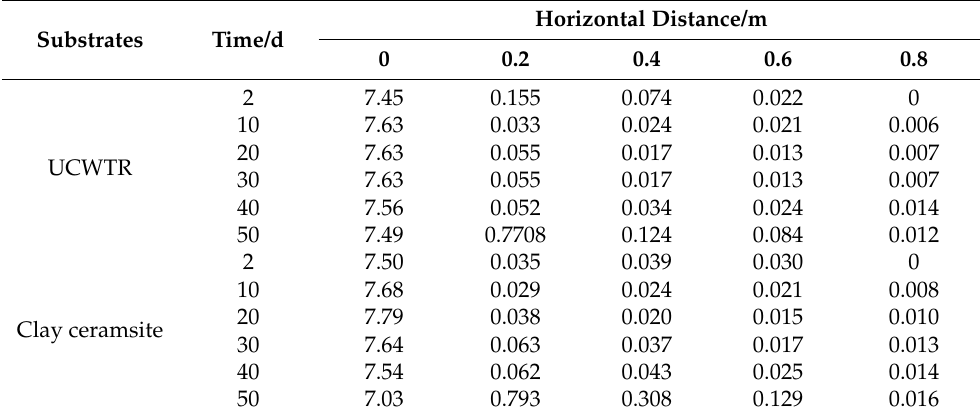
Table 4. Change in horizontal Cd concentration at 2 d, 10 d, 20 d, 30 d, 40 d, 50 d (mg/L).